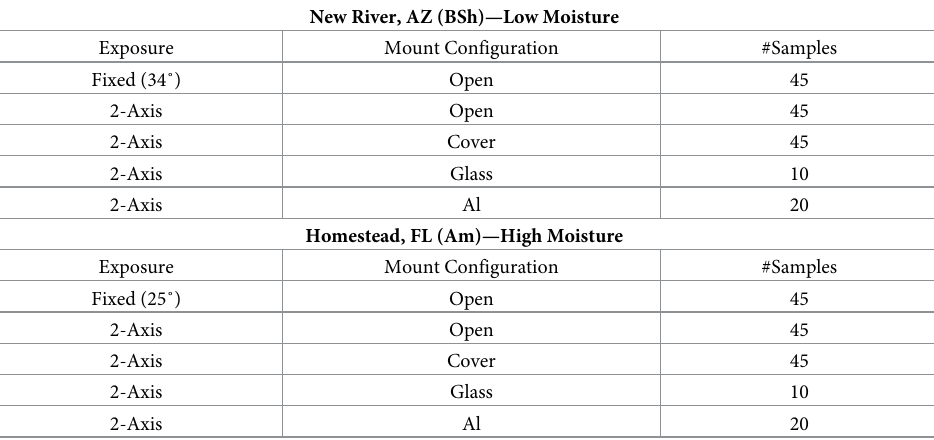
Table 3. Summary of outdoor exposures. Fixed angle exposures are followed by the tilt angle of the exposures. “2-Axis” refers to exposures conducted on 2-axis solar trackers. “#Samples” is the total number of samples under each exposure configuration. Ko¨ppen-Geiger climate zone categories are given in parenthesis beside the locations